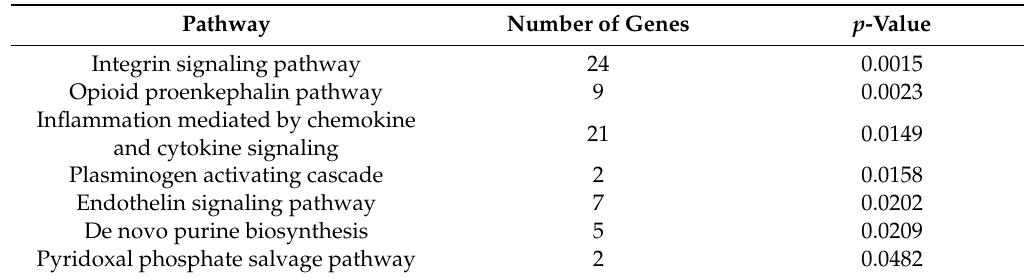
Table 3. Pathway-related Panther gene enrichment test based on all significantly di ff erentially expressed genes and their fold expression di ff